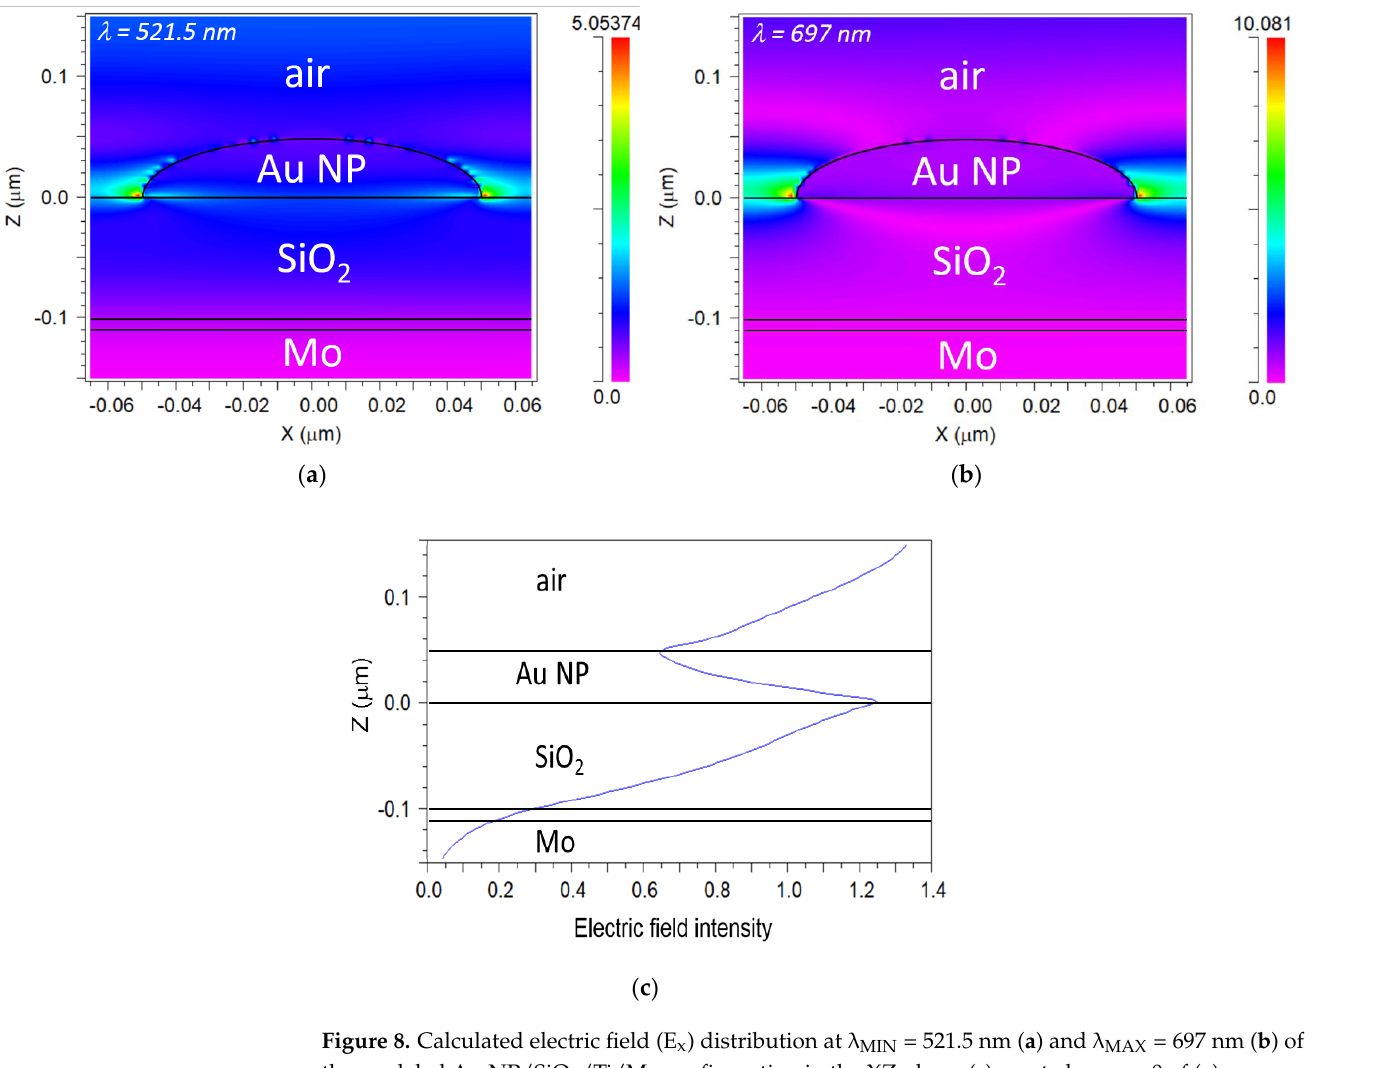
8 of 13 Figure 7. Calculated spectral reflection for different multilayer configurations: SiO 2 (100 nm)/Ti (10 nm)/Mo substrate (blue line), Au (15 nm)/SiO 2 (100 nm)/Ti (10 nm)/Mo substrate (green line), Au NP (100 nm diameter)/SiO 2 substrate (red line), and Au NP (100 nm diameter)/SiO 2 (100 nm)/Ti (10 nm)/Mo substrate (black line). In all cases n B = 1 (air).